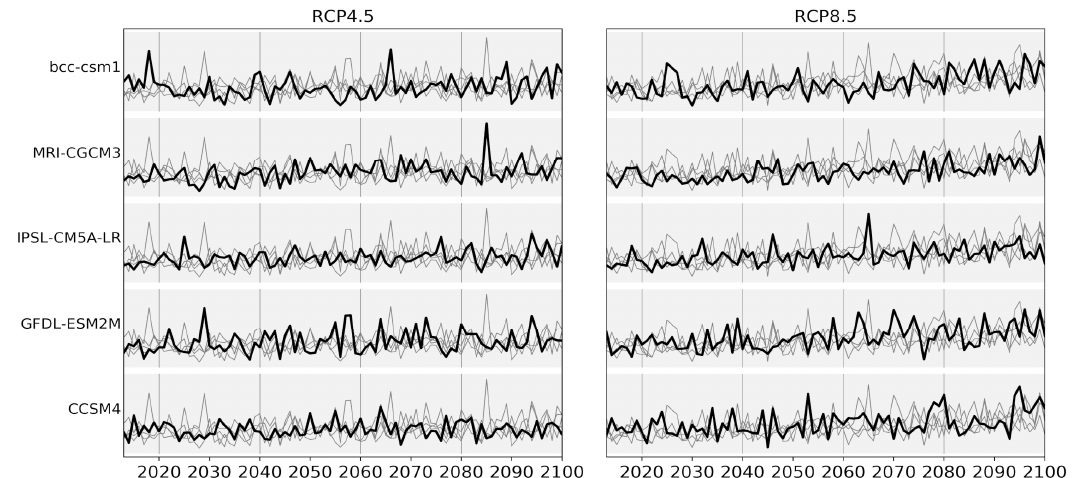
Figure 5. The projected monthly inflow changes in Liyuan between projected 2020 – 2100 monthly average and historical 1961 – 2016 monthly average.